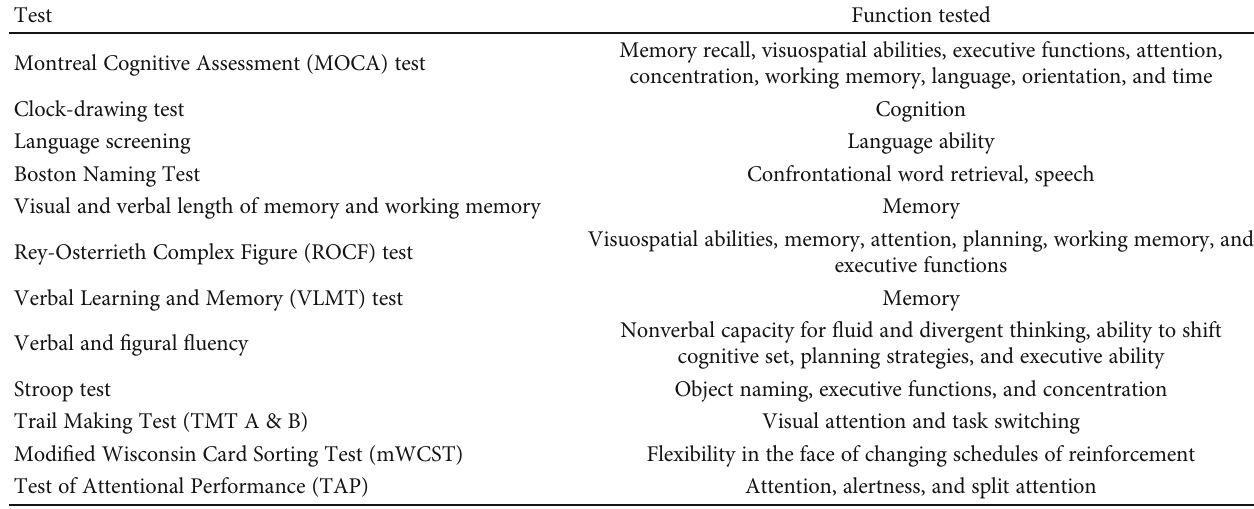
Table 3: Recommended neuropsychological test battery for neurocognitive evaluation before and after neuroendoscopic